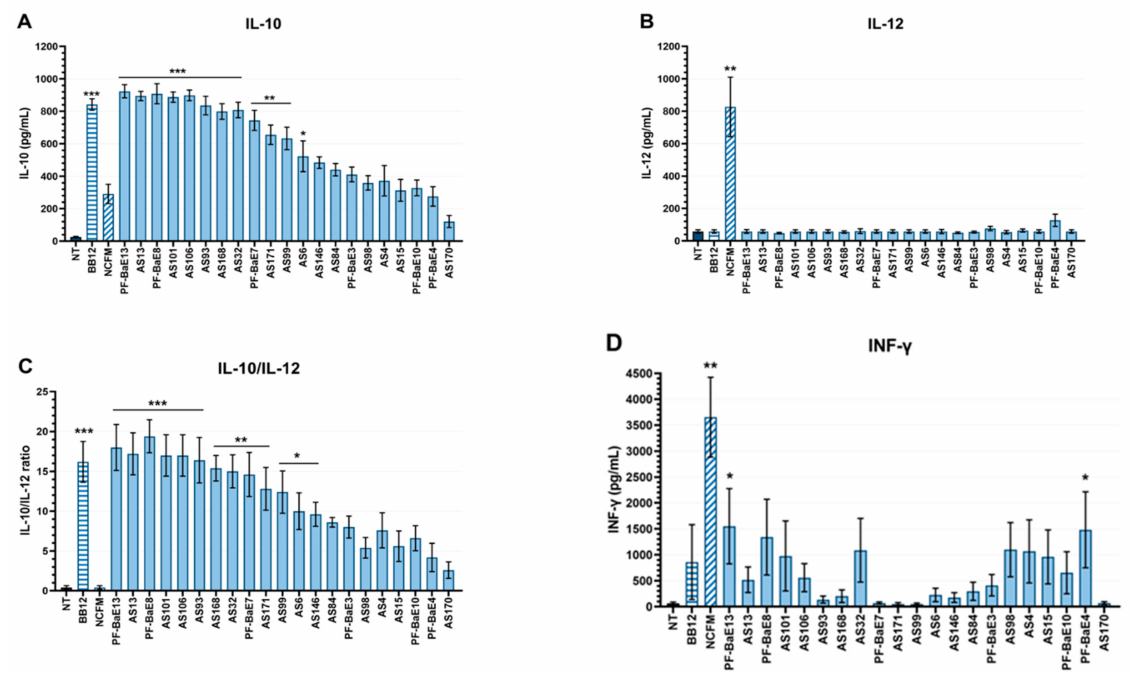
Figure 4. In vitro immunomodulatory profiles after PBMCs stimulation by the selected bacteria. PBMCs were stimulated 24 h with the selected strains or two reference strains: L. acidophilus NCFM (NCFM) and B. animalis subsp. lactis BB12 (BB12) at a ratio of 10:1 (bacteria:cells). The cytokine levels were measured by ELISA in the various samples and the untreated cells (NT). Data represent means ± SEM of 5 independent donors. Levels of ( A ) IL-10, ( B ) IL-12, and ( D ) IFN γ were measured in the supernatants. ( C ) IL-10/IL-12 ratios. * p < 0.05, ** p < 0.01; *** p < 0.001 in comparison with untreated